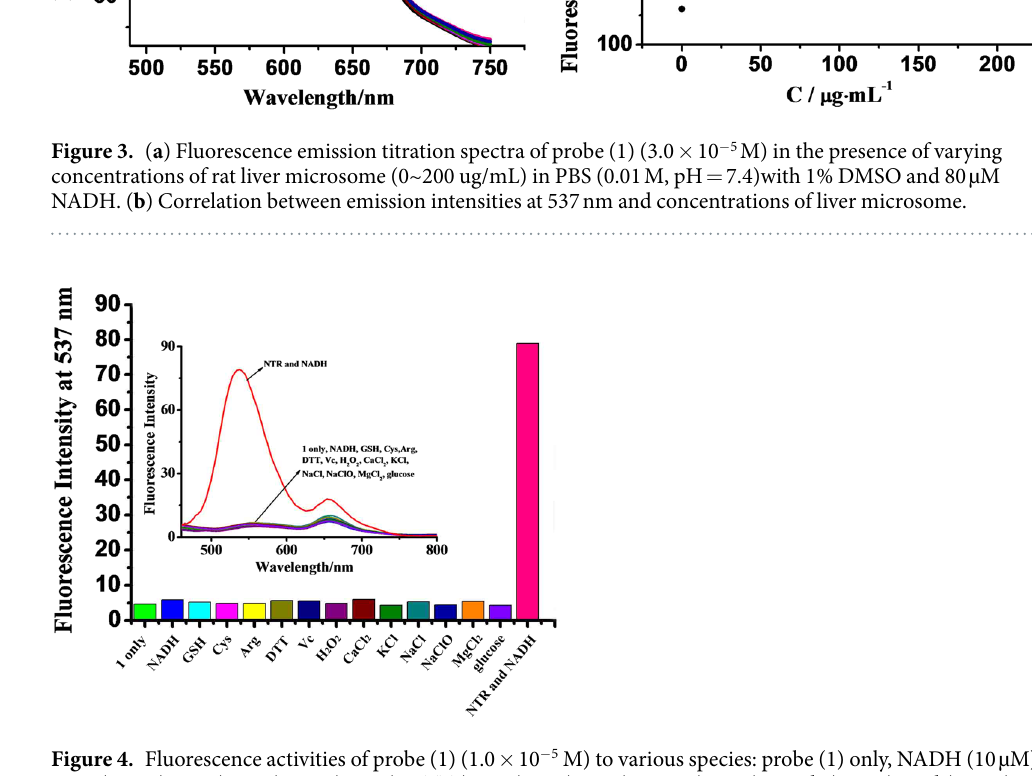
Figure 4. Fluorescence activities of probe (1) (1.0 × 10 − 5 M) to various species: probe (1) only, NADH (10 µ M), GSH (1 mM), Cys (1 mM), Arg (1 mM), DTT (1 mM), Vc (1 mM), H 2 O 2 (1 mM), CaCl 2 (1 mM), KCl (1 mM), NaCl (1 mM), NaClO (1 mM), MgCl 2 (1 mM), glucose (1 mM), nitroreductase, and NADH. All measurements were performed in PBS (0.01 M, pH 7.4) with 1%